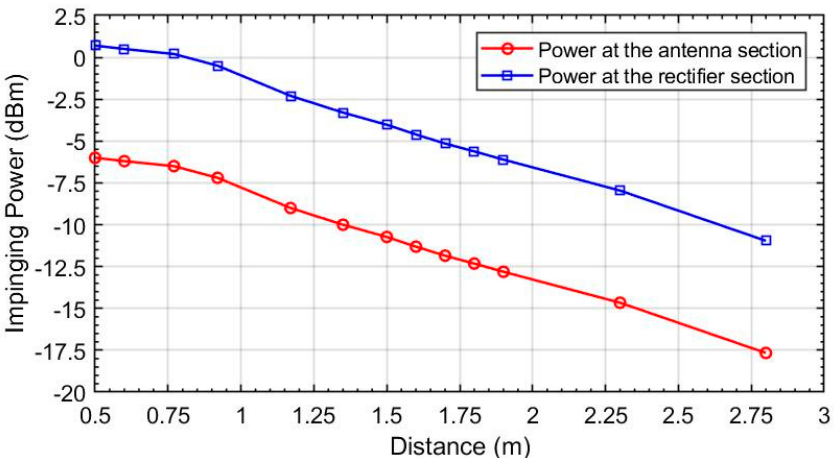
Figure 13. Impinging power from the roadside unit (RSU) at the antenna section (measured) and at the rectifier section (evaluated).